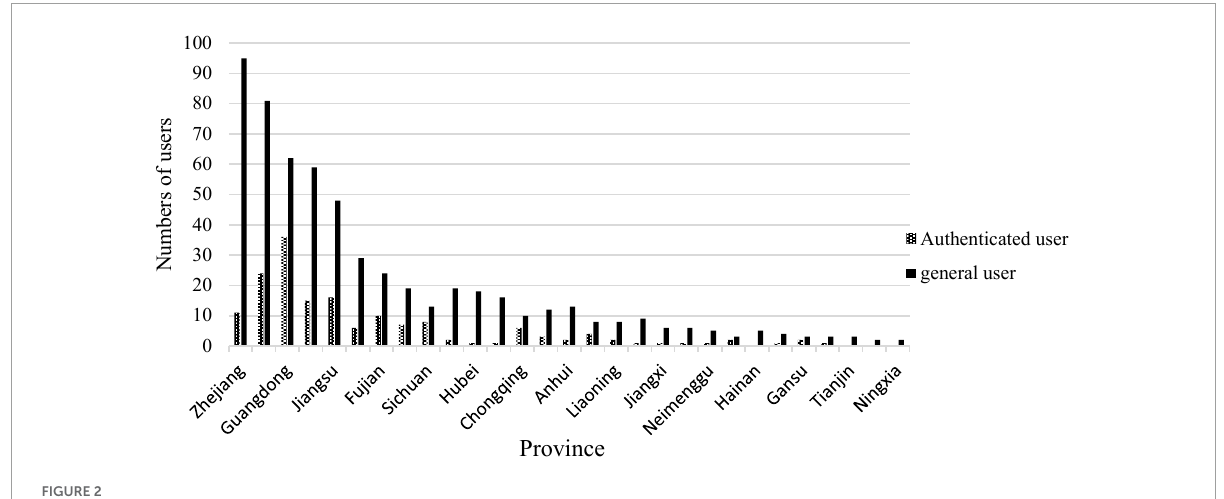
FIGURE2 Statistics on the characteristics of perceived subjects based on